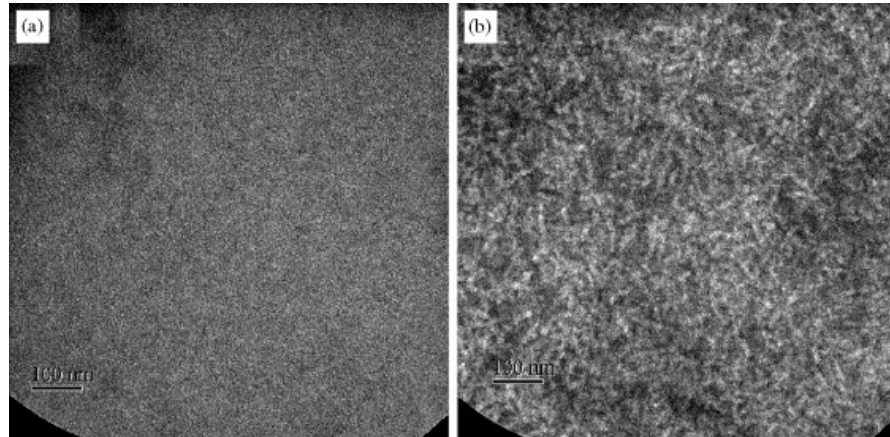
Figure 10. TEM images of a P3HT:PCBM 1:1 blend: ( a ) before and ( b ) after annealing at 100 °C. Reprinted with permission from Elsevier [80].